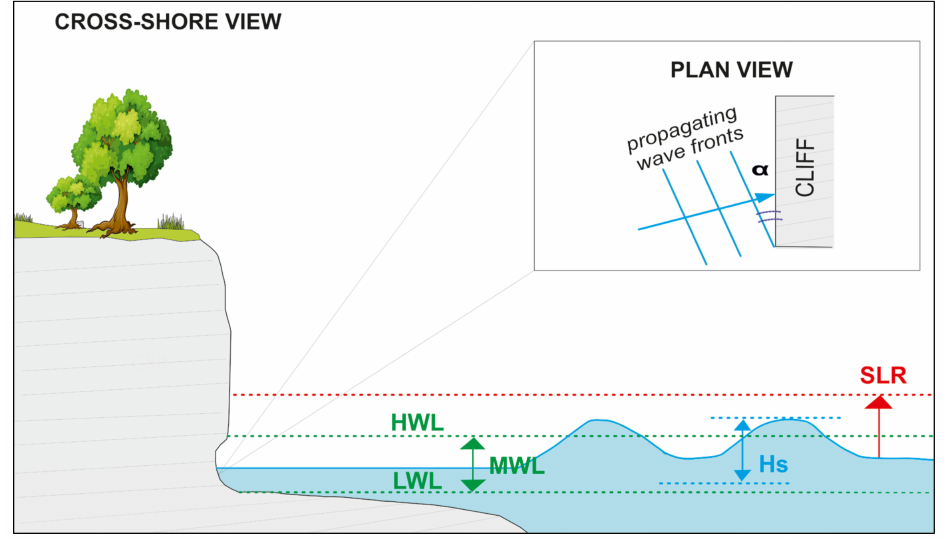
Figure 2. Cross-shore view of the main coastal forcing acting on a cliff. H s : Significant wave height; MWL: Mean water level; α : waves’ approaching angle. It indicates the degree of littoral exposition to wave fronts; SLR: Relative Sea Level